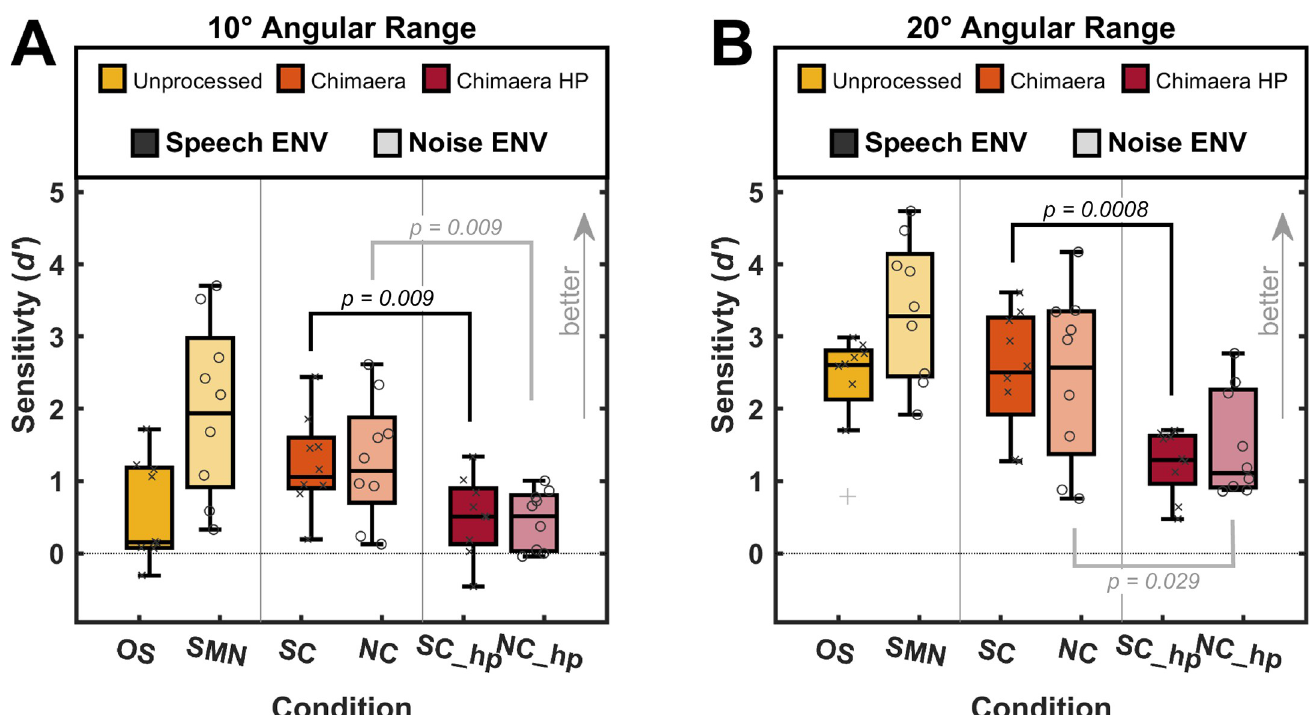
Fig 2. Sensitivity values for Experiment I and II. (A) Sensitivity values ( d’ , y-axis) for motion detection when sounds were stationary or moved 10˚ angular distance across conditions (x-axis). Plotted are boxplots with group medians (black line) and individual data (individual markers) superimposed. Data are organized by stimulus category (color legend), and ENV type is indicated by color intensity (legend). Plus-signs denote outliers. (B) same as (A) for motion detection when sounds were stationary or moved 20˚ angular distance.